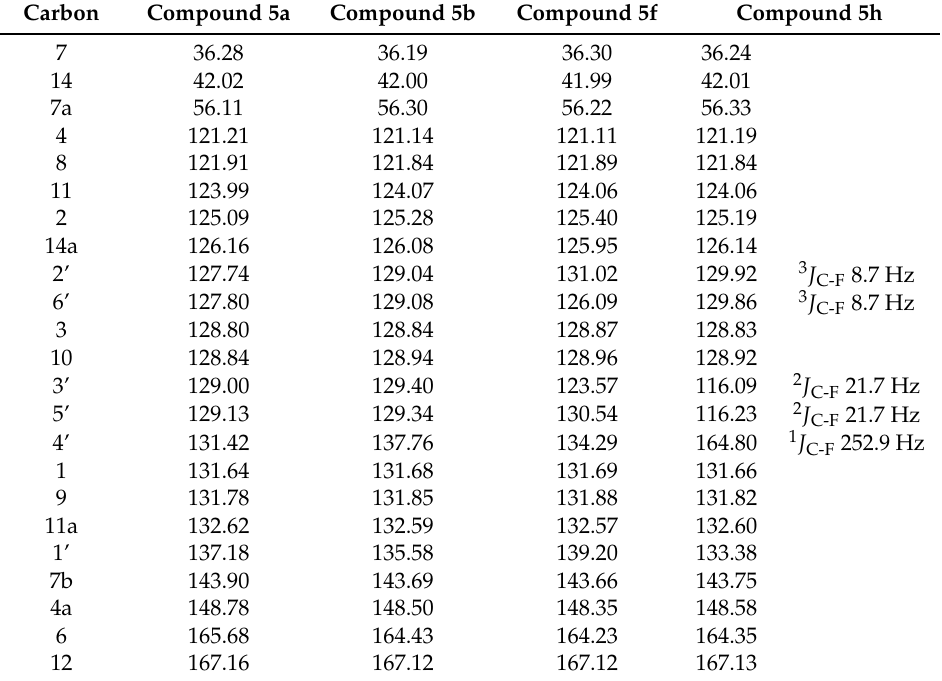
Table 4. Carbon NMR assignments of compounds 5a , 5b , 5f and 5h (chemical shifts, ppm) [a] .